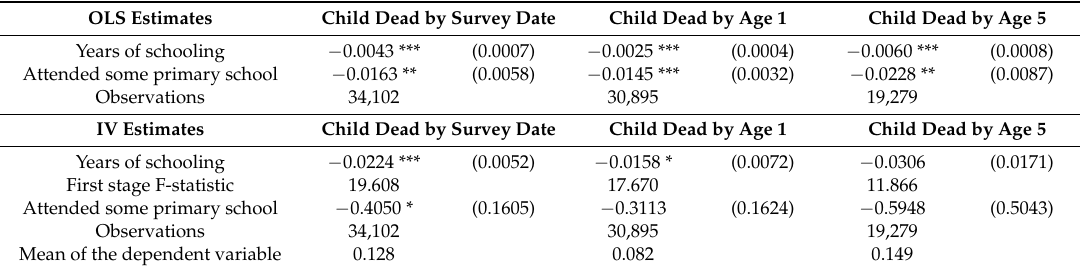
Table 3. Effect of maternal education on child